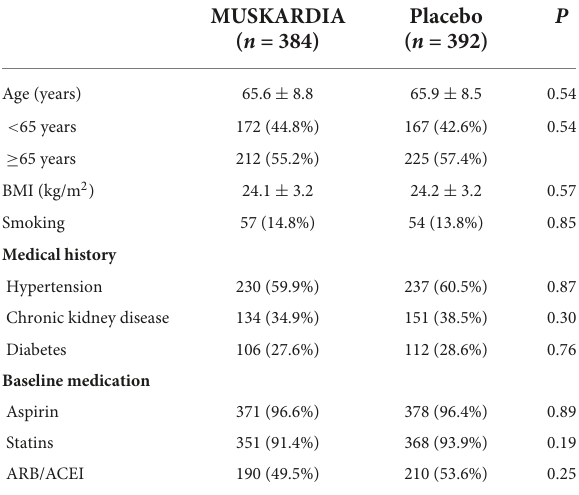
TABLE 1 Baseline information of the female